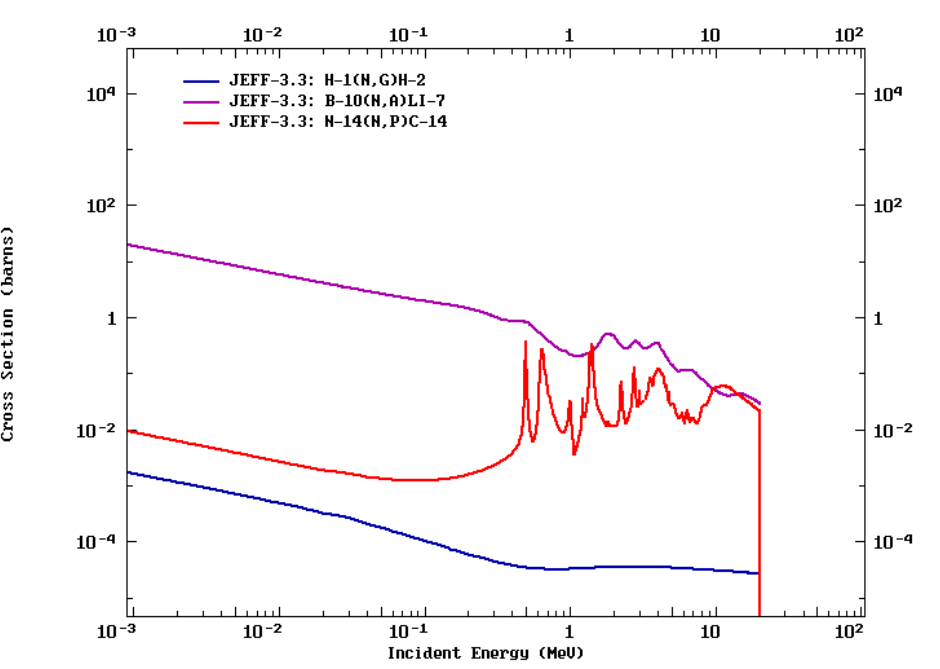
Figure 4. Cross-sections of reactions that take place because of neutron collisions. 1 H ( n , γ) 2 H (blue), 10 B ( n , α) 7 Li (magenta), 14 N ( n, p ) 14 C (red). The figure was plotted using data from ENDF [64].